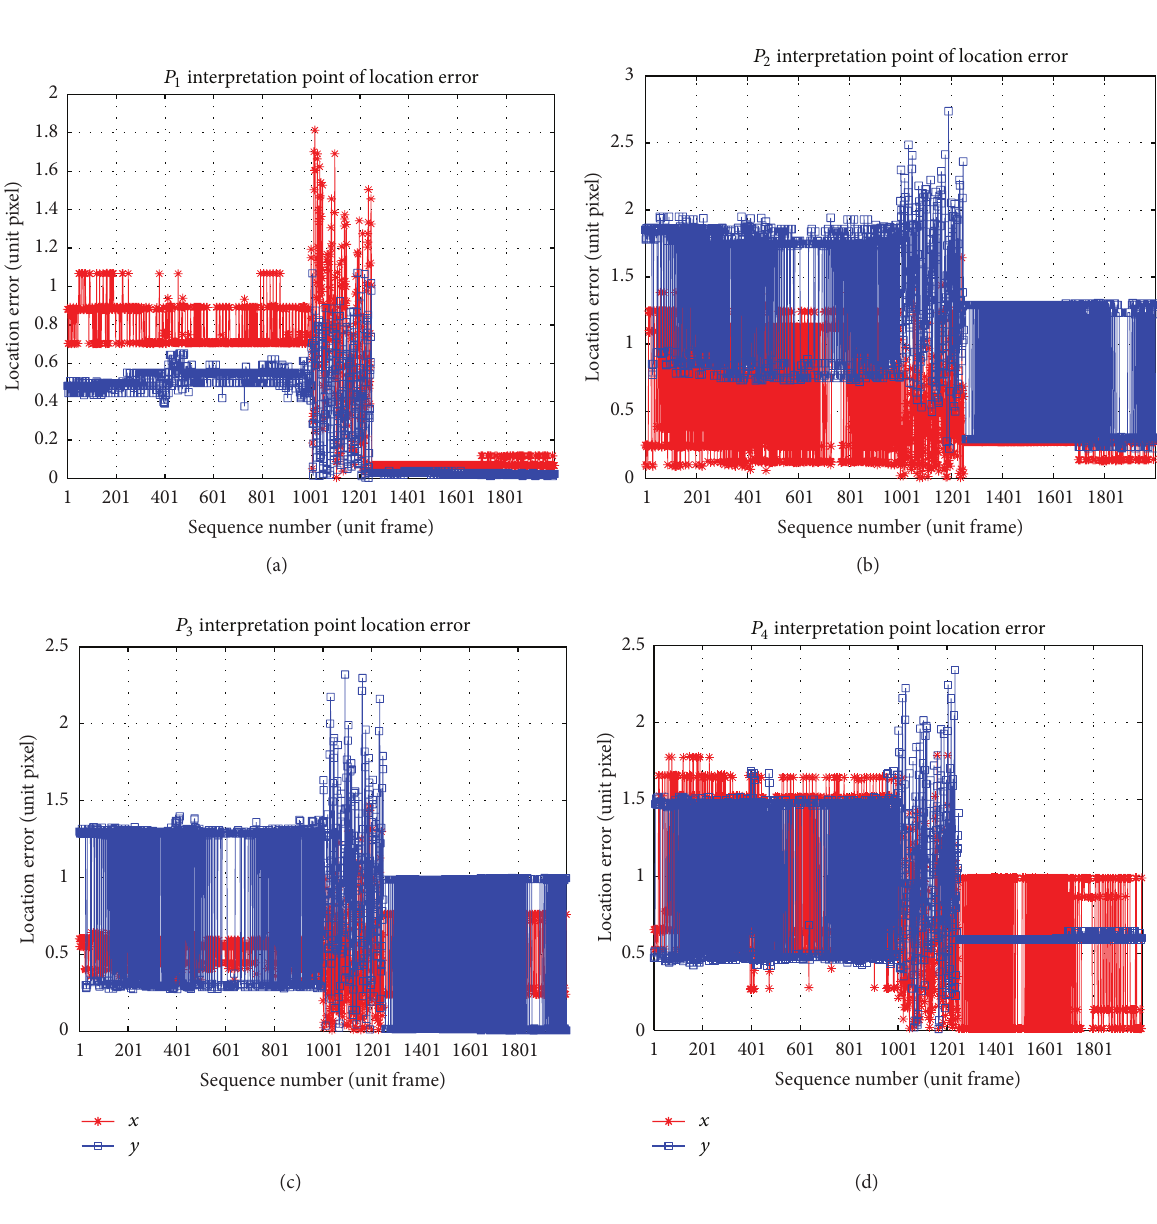
Figure 13: Plots of location precision of multiple interest points for left